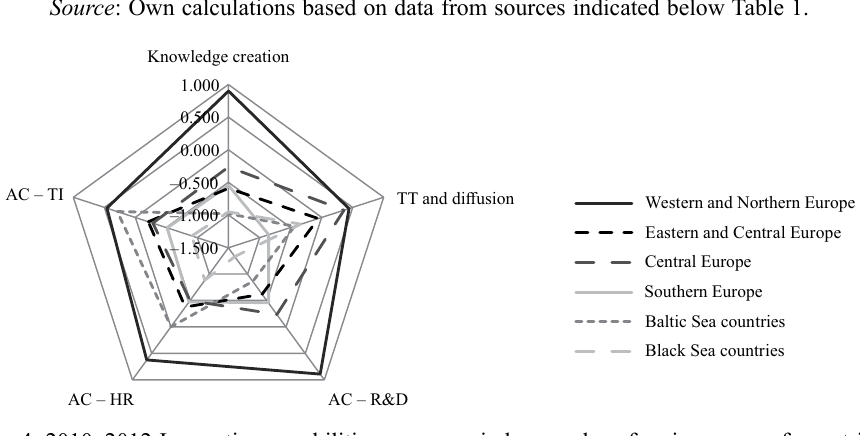
Fig. 4. 2010–2012 Innovation capabilities summary indexes values for six groups of countries Note: see Figure 3. Source : Own calculations based on data from sources indicated below Table